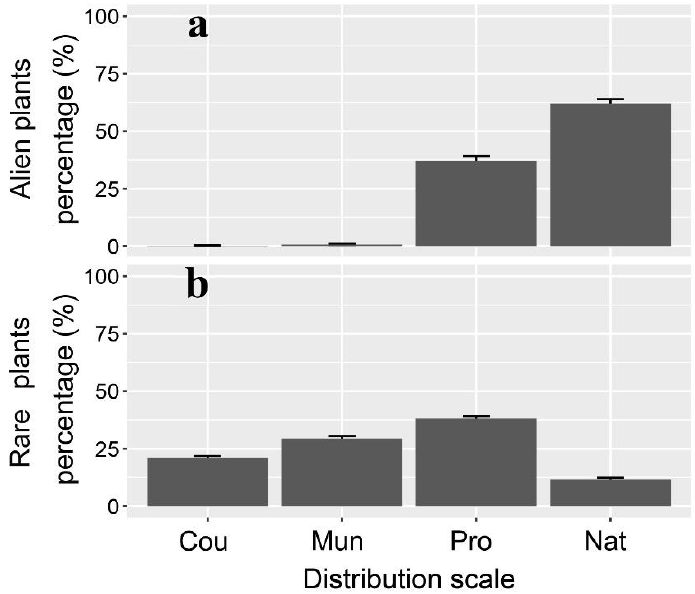
Figure 5. Percentage of distribution scale of alien ( a ) and rare plants ( b ). Cou, county scale; Mun, municipal scale; Pro, provincial scale; Nat, national scale. Error bars represent standard error .